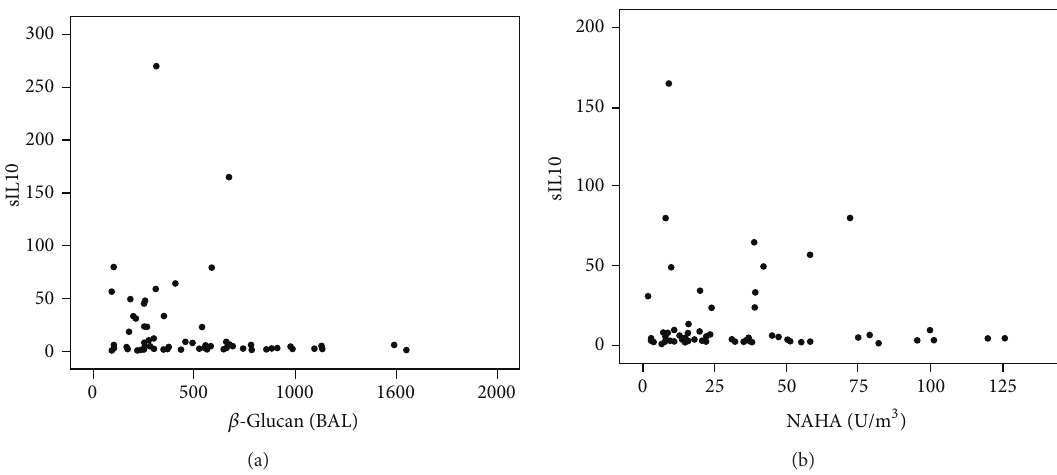
Figure 1: (a) Serum IL-10 in relation to the amount of 𝛽 -glucan (BAL) pg/mL ( 𝑛 = 70 ) and (b) NAHA in homes ( 𝑛 = 60 ) of subjects with